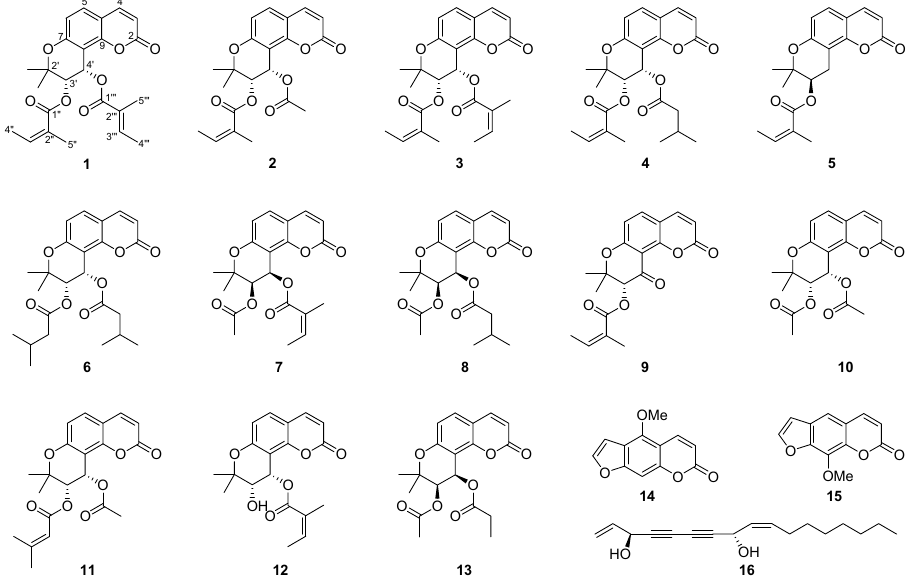
Figure 1. Structures of compounds 1 – 16 isolated from root extracts of Peucedanum praeruptorum.